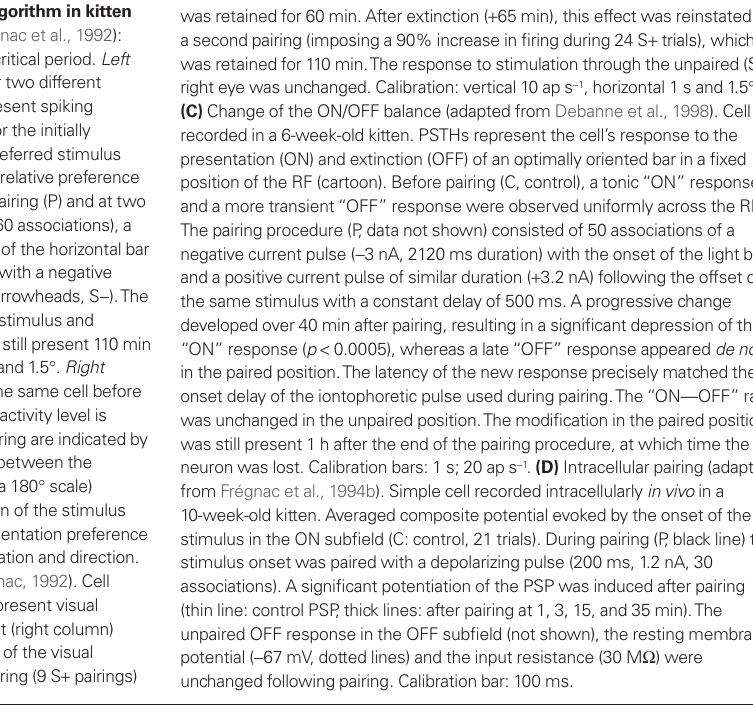
Figure 2 | Functional impact of the covariance-based algorithm in kitten V1. (A) Change in orientation preference (adapted from Frégnac et al., 1992): Cell recorded in a visually deprived kitten at the peak of the critical period. Left panel: PSTHs represent visual responses to a moving bar for two different orientations (40 runs each). Superimposed dot displays represent spiking responses for each individual trial. Left column, responses for the initially preferred stimulus (vertical orientation). Right, initially non-preferred stimulus (horizontal orientation). From top to bottom, evolution of the relative preference as a function of time, before (C: control), during differential pairing (P) and at two delays following pairing. During pairing (P, filled histograms, 60 associations), a positive current pulse ( + 3 nA) was applied during the sweep of the horizontal bar across the discharge field (arrowheads, S + ), and interleaved with a negative current pulse ( − 7 nA) when the vertical bar was presented (arrowheads, S − ). The visual response became respectively potentiated for the S + stimulus and depressed for the S − orientation ( + 10 min). The effects were still present 110 min after pairing. Calibration bars: vertical 5 ap s − 1 , horizontal 1 s and 1.5 ° . Right panel : Polar orientation tuning curves were established for the same cell before (Control) and after pairing ( + 10 min). The mean spontaneous activity level is shown by the stippled area. The orientations used during pairing are indicated by S + /S − symbols. The lower graph represents the differences between the normalized tuning curves before and after pairing (folded on a 180 ° scale) expressed as gains and losses as a function of the orientation of the stimulus (calibration: ± 20%). Following pairing, the cell changed its orientation preference by 90 ° , and became tuned to the positively-reinforced orientation and direction. (B) Ocular dominance change (adapted from Shulz and Frégnac, 1992). Cell recorded in a 4.5-week-old normally reared kitten. PSTHs represent visual responses to stimulation of the left (left column) and the right (right column) eyes, before and after two pairings (thick lines). The increase of the visual response to the left eye ( + 40%), imposed during the first pairing (9 S + pairings)